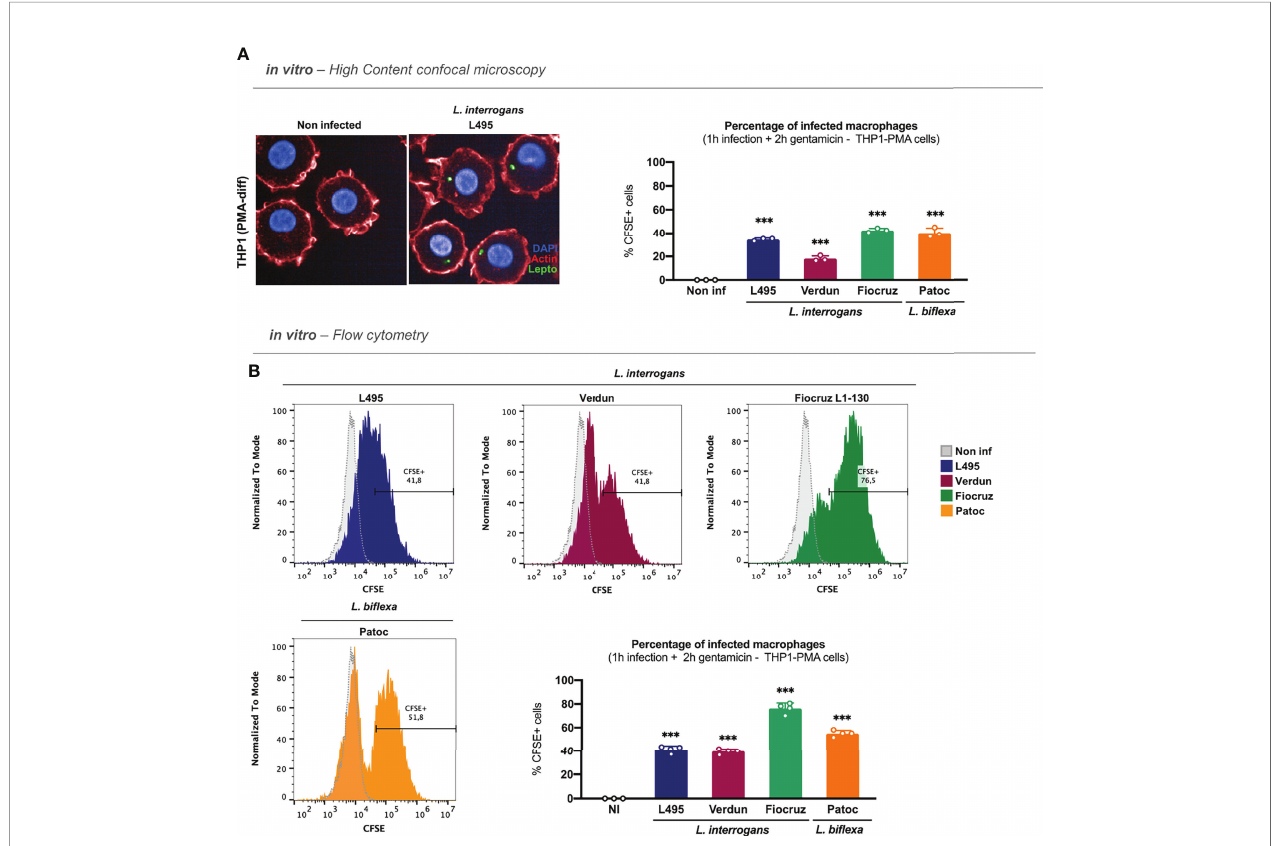
FIGURE 2 | Leptospires are also internalized in human macrophages. (A) High-content (HC) confocal microscopy images and analyses of PMA – differentiated THP1 cells infected for 1 h with MOI 100 of CFSE-labeled L. interrogans serovar Manilae strain L495, serovar Copenhageni strain Fiocruz L1 – 130, serovar Icterohaemorrhagiae strain Verdun, and L. bi fl exa serovar Patoc strain Patoc I and after gentamicin protection assay. (B) Flow cytometry histograms and analyses of PMA – differentiated THP1 cells infected for 1 h with MOI 100 of CFSE-labeled L. interrogans serovar Manilae strain L495, serovar Copenhageni strain Fiocruz L1 – 130, serovar Icterohaemorrhagiae strain Verdun, and L. bi fl exa serovar Patoc strain Patoc I and after gentamicin protection assay. (A, B) Bars correspond to mean +/- SD of technical replicates ( n = 3). Data presented are representative of at least two independent